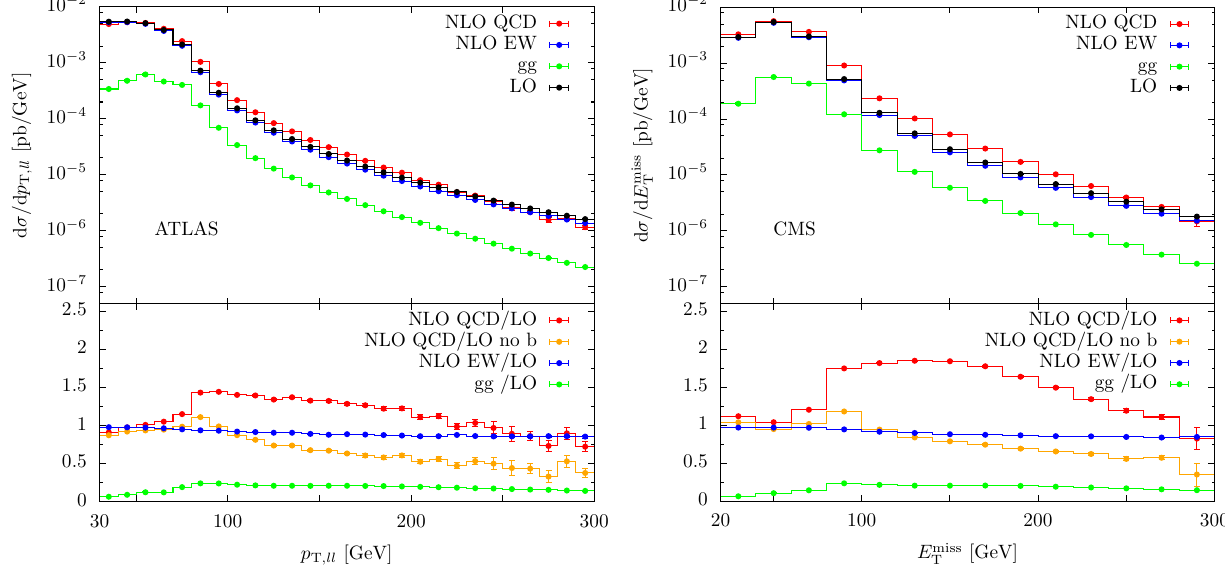
Fig. 5 Differential distribution in the transverse momentum of the charged-lepton pair ( p T , ll ) and in the missing transverse momentum ( E miss √ s = 13TeV under the event selections of Eqs. (4.4) and (4.5). Same notations and conventions as in Fig. for the process pp → e + ν e μ − ¯ ν μ at